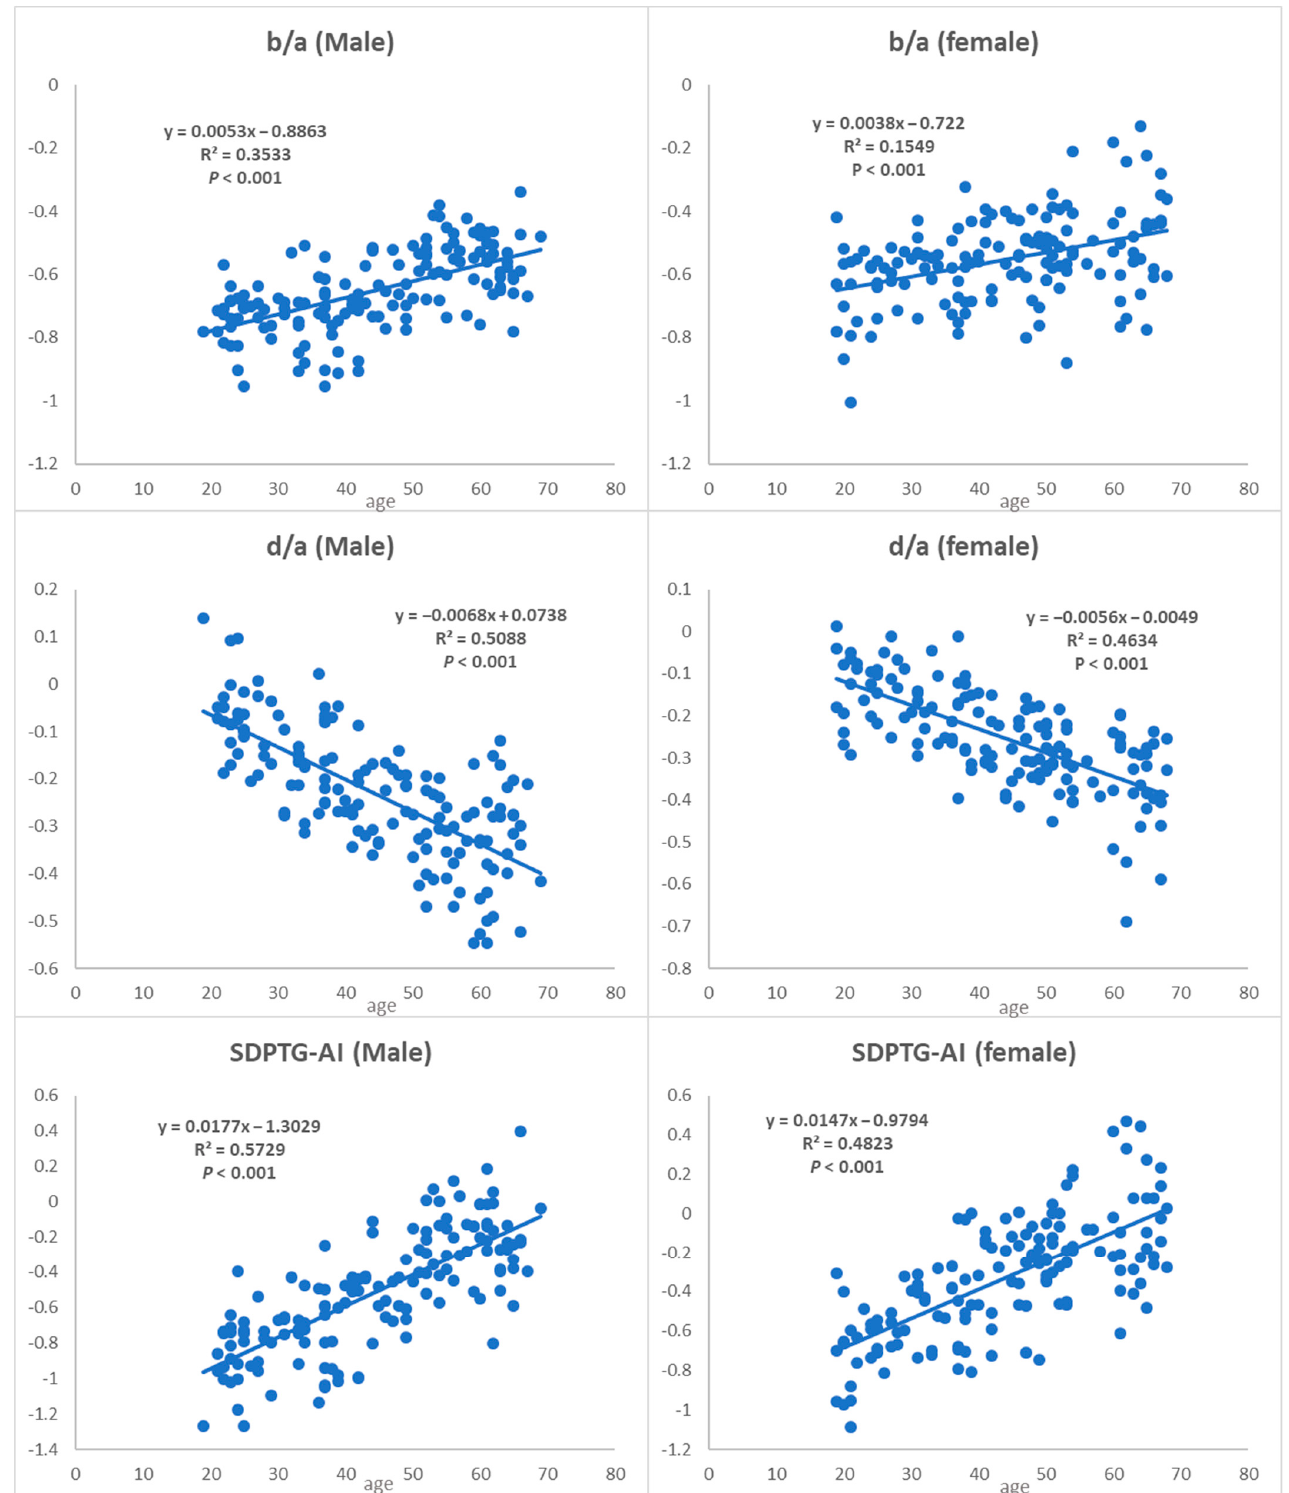
Figure 4. Variations in major second derivative photoplethysmogram (SDPTG) indices between male and female groups.